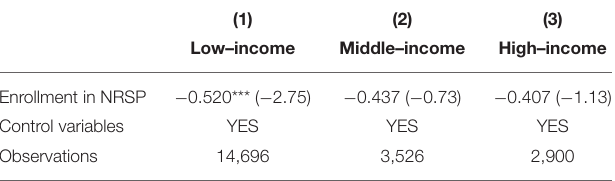
TABLE 7 | Heterogeneity by income